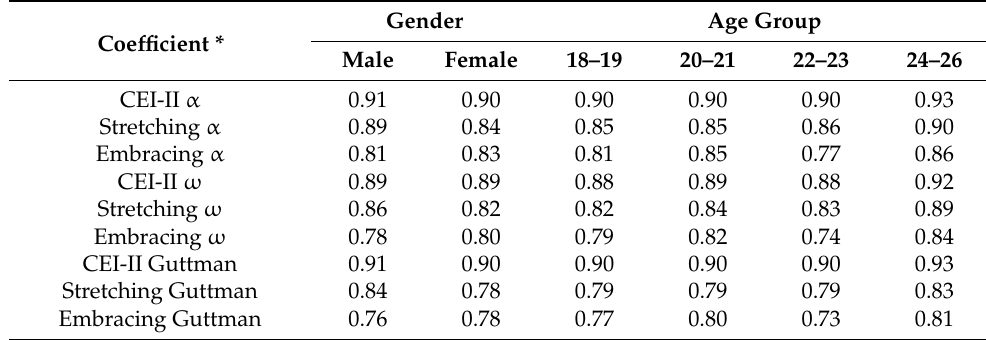
Table 5. Internal consistency coefficient by gender and age group.